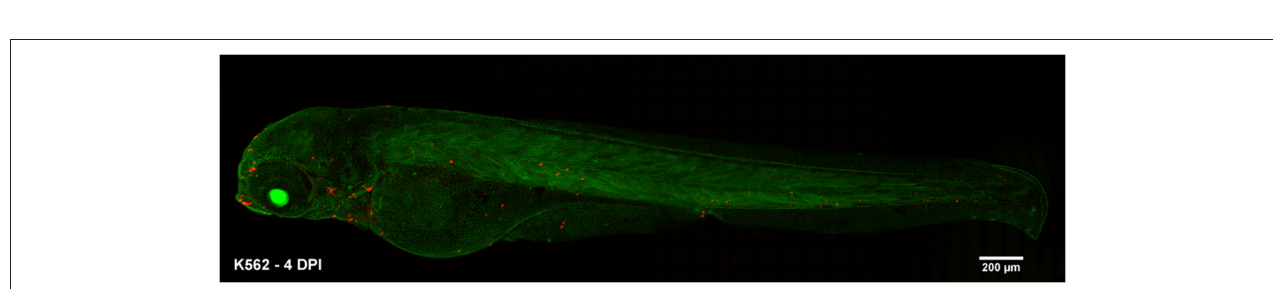
FIGURE 7 | PLS-DA score plot of the clinical outcome predicted by the integrative model. (A) Infographic scheme of the mathematical model (B) Clinical information, LSC characterization and in vivo behavioral analysis explains 44% of the variance between patients newly diagnosed with acute leukemia and discriminate accurately the patients into a successful and unsuccessful clinical outcome after induction treatment. Component 1 discriminated better the patients according to their clinical outcome into successful or unsuccessful remission. The most influential variables with respect to the clinical outcome corresponded to ALDH activity, LSC proportion, and migration along zebrafish embryos. 1, successful morphological remission; 0, Unsuccessful morphological remission.